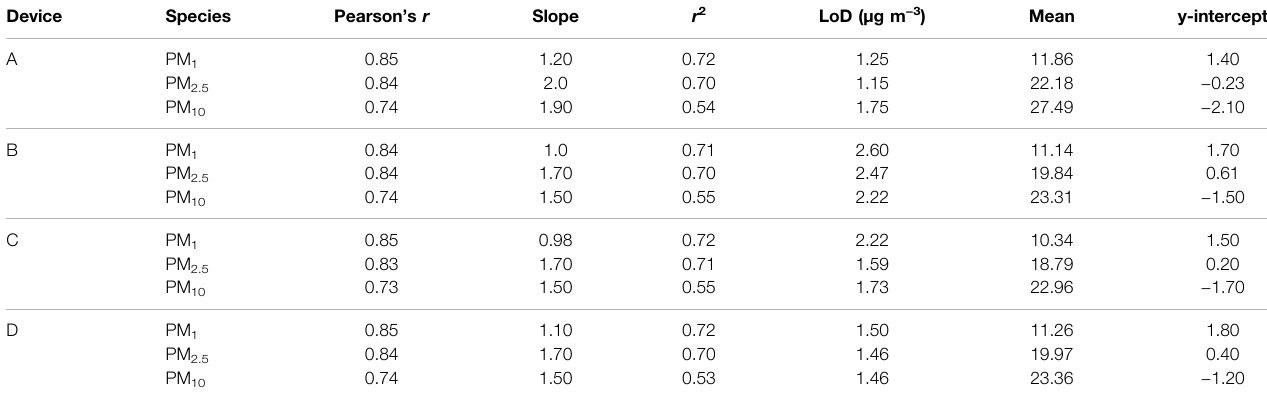
TABLE 2 | Correlation coef fi cients and statistics for low-cost devices ( R , r 2 , and slope are in comparison to Birmingham Air Quality Supersite FIDAS).